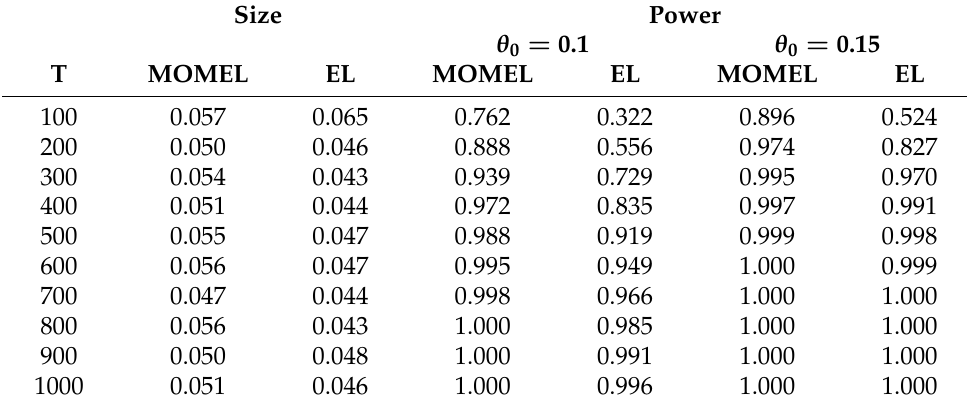
Table 5. Size and power in Example